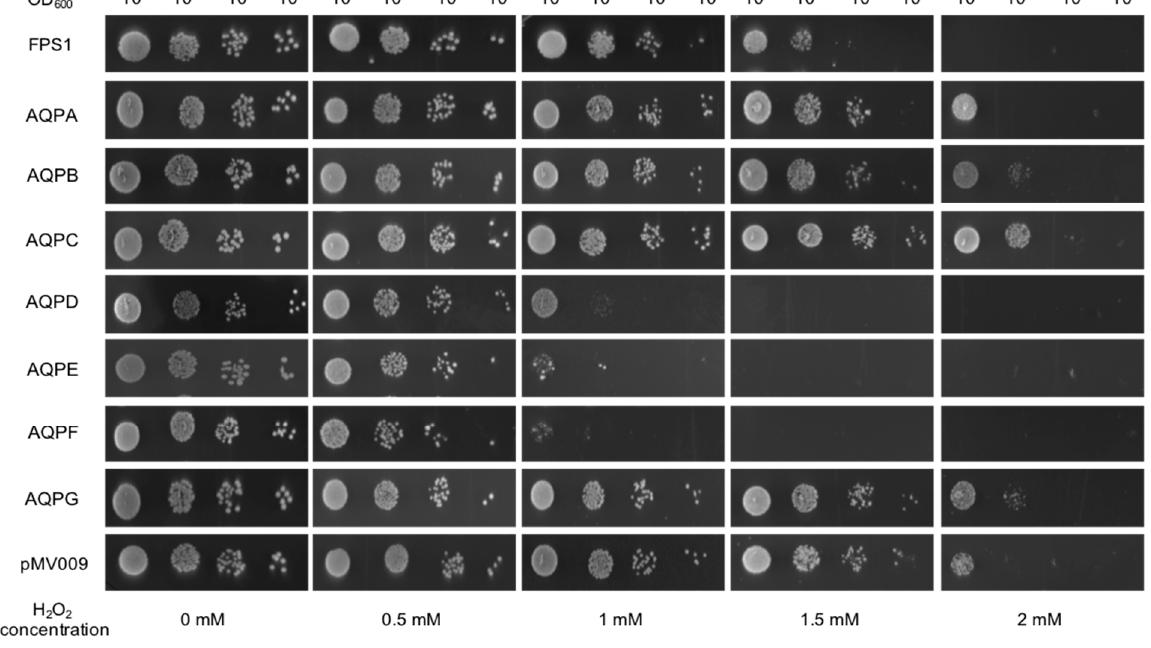
Figure 2. Growth and survival analysis of S. cerevisiae expressing A. niger AQPs in the presence of hydrogen peroxide. Overnight yeast cultures were diluted to an OD 600 of 0.1, and subsequently, serial dilutions were done from this one. Five–µL of cell suspensions were spotted on agar plates containing various hydrogen peroxide concentrations (0–2 mM). Growth phenotype was recorded after incubating for 6 days at 30 °C. The data shown are representative of three independent experiments with consistent results.